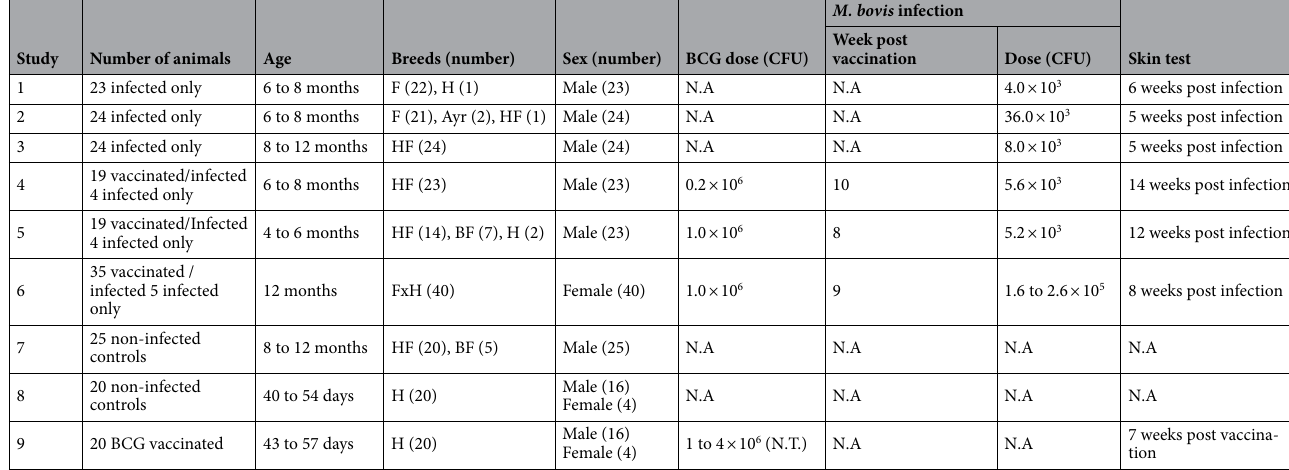
Table 1. Overview of the cattle studies for DST-F performance data. HF, Holstein–Friesian; H, Holstein; BF, British Friesian; FxH, Friesian cross Hereford; F, Friesian; Ayr, Ayrshire; N.A., Not applicable; N.T., Not titrated.